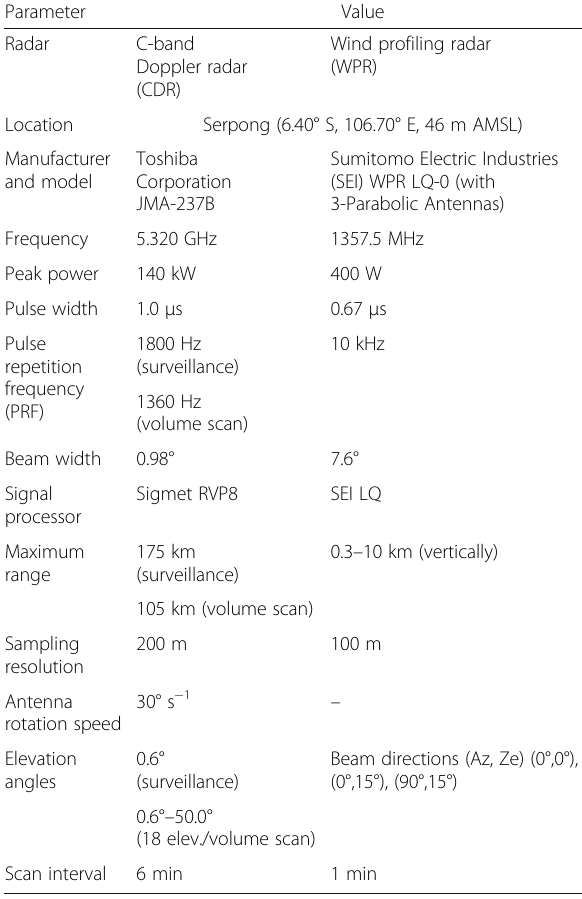
Table 1 Major specifications of Serpong CDR and WPR, and their operating condition during the HARIMAU2010